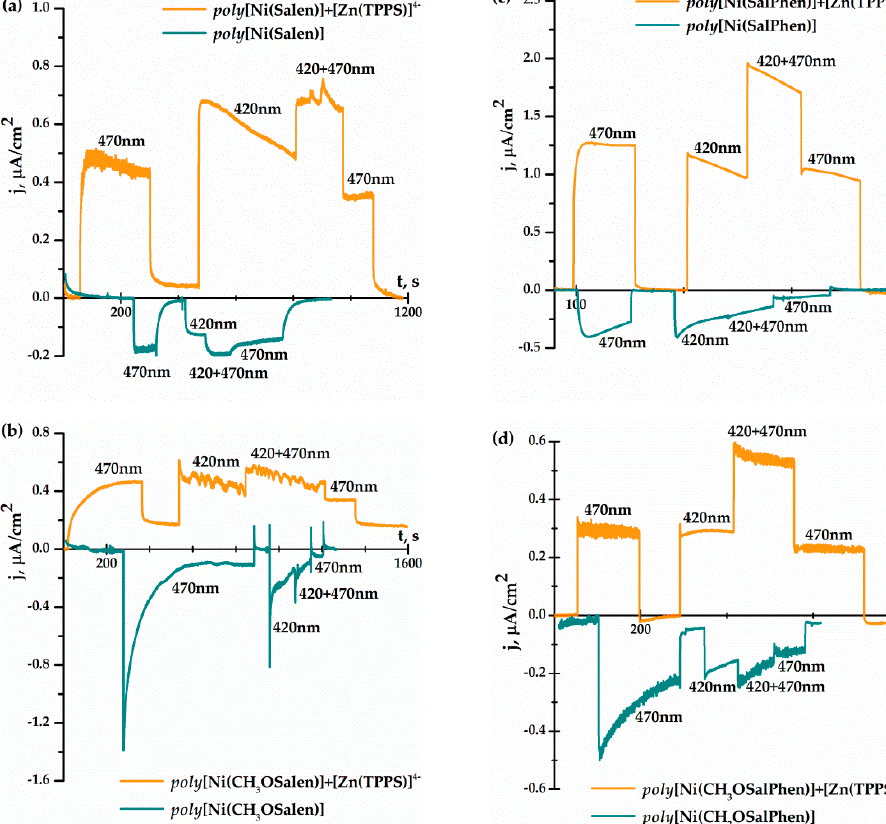
Figure 3. Anodic photocurrent by the pristine and ZnTPPS-doped ( a ) poly [Ni(Salen)]; ( b ) poly [Ni(SalPhen)]; ( c ) poly [Ni(CH 3 OSalen)]; ( d ) poly [Ni(CH 3 OSalPhen)] films on ITO. Phosphate buffer, Ph = 6.86, 0.1 M ascorbic acid.